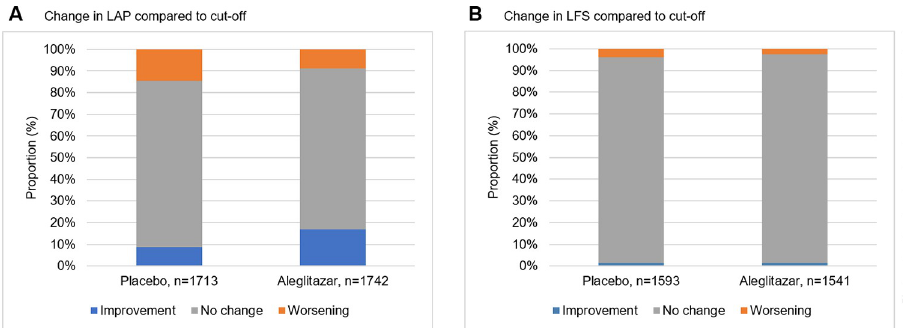
Fig 4. Change in LFS and LAP compared to cut-off values at baseline until 24 months follow-up. Proportion of randomized patients that either improved (lnLAP below cut-off < 4 for males and < 4.4 for females, LFS below cut-of < -0.640), worsened (lnLAP above cut-off > 4 for males and > 4.4 for females, LFS above cut-off > -0.064), or did not change in respect to respective cut-off value. Proportion of change is significantly different between treatment and placebo for LAP (A) , both improvement and worsening P < 0.001. For LFS (B) only worsening is significantly less in the treatment group, improvement P = 0.974, worsening P =